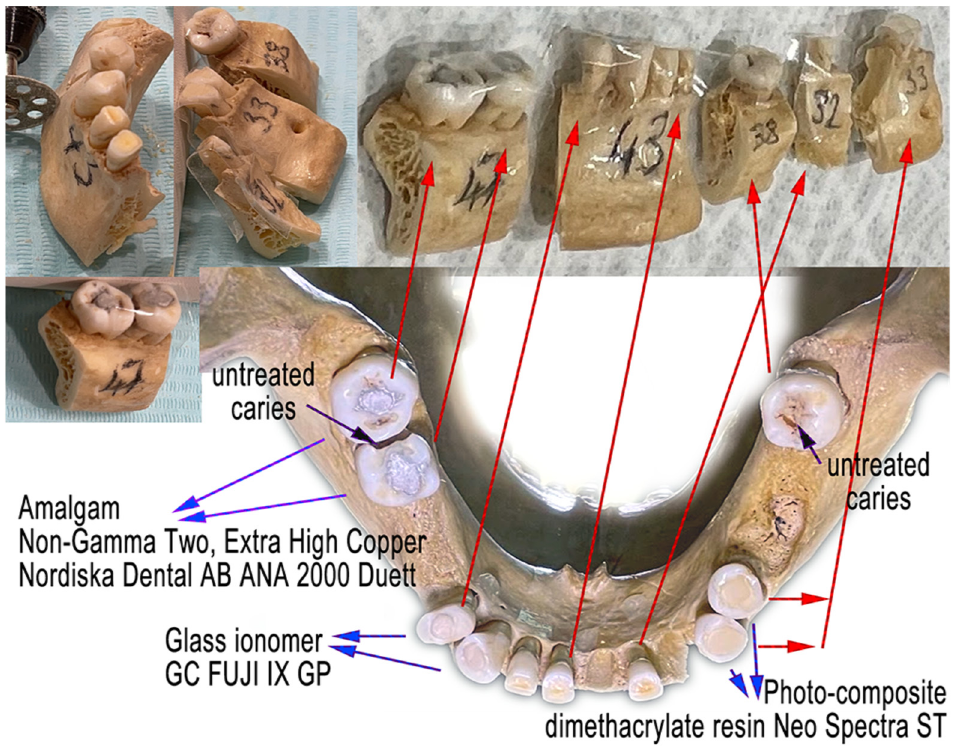
Figure 6. The mandible was cut into five samples and labeled (47, 43, 38, 32 and 33) to allow repeated sequences of sulfuric acid bathing, triple washing, drying, photographing and micro-CT scanning.